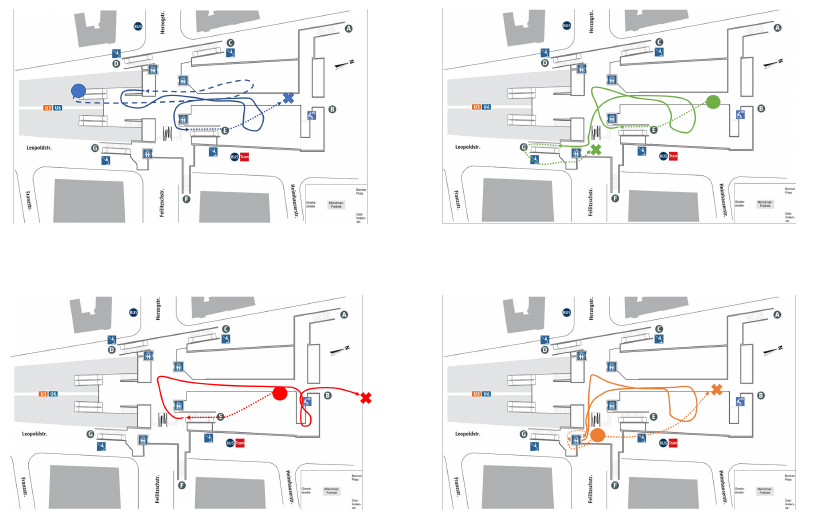
Figure 3. Designed 3D trajectories in the test station. The dots indicate where the trajectories start and the crosses where they end. The dashed lines indicate the lower floor; the solid lines indicate the main floor; the dotted lines indicate the upper